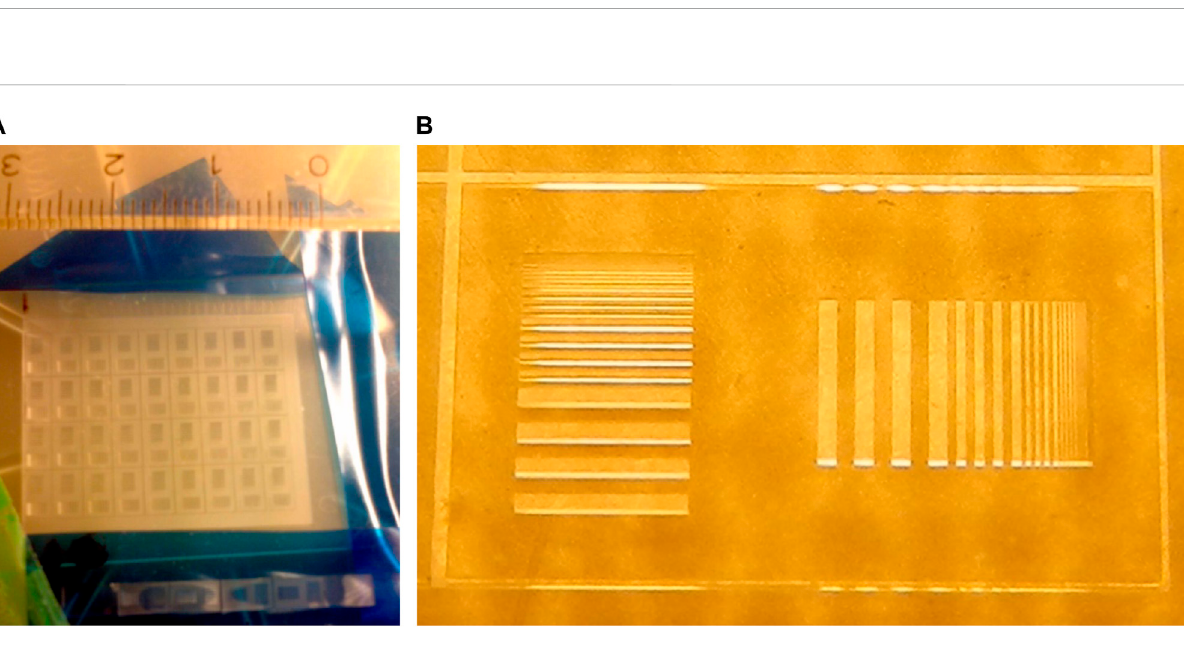
FIGURE 3 (A) PhotoofasectionofthestructuredPMMAplatewithseveralresolutionphantomgridsets.Therealizedgridperiodsa i varybetween256,128,64, 32, 16 and 8 µm. The scale indicates cm. (B) Macro photo of one of the phantom prototypes. Two sets of grids are arranged in orthogonal directions for independent analysis of the spatial resolution in phase and frequency encoding direction in 2D-FT MR-imaging. The largest grid with period a 1 = 256 µm can be seen, e.g., at the bottom